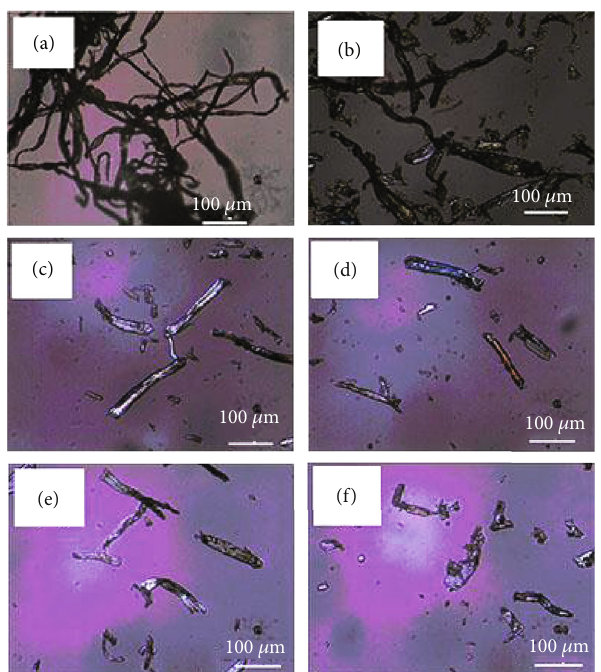
Figure 2: Polarizing microscope micrograph (100 × ) of WPF before and after hydrolysis and OWPF with di ff erent oxidation degrees: (a) before hydrolysis; (b) after hydrolysis (0); (c) 0.125 OWPF; (d) 0.25 OWPF; (e) 0.375 OWPF; (f) 0.5